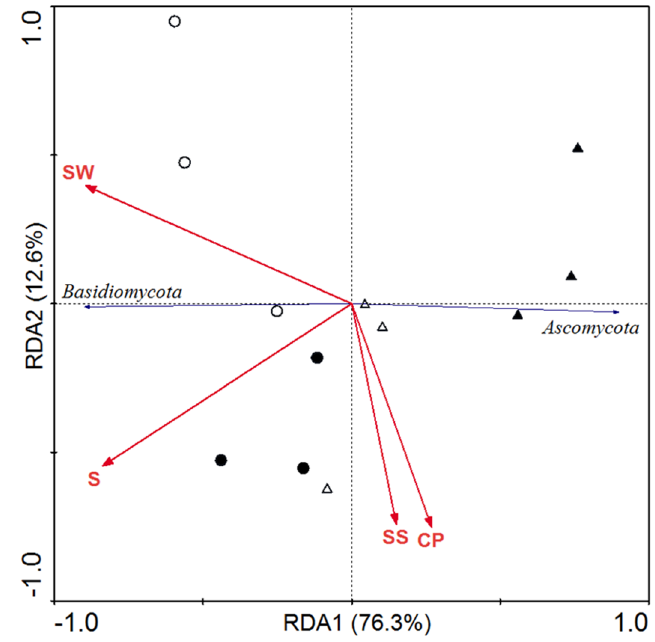
Figure 7. Redundancy analysis (RDA) plots showing the influence of physiological characteristics (water, CP, soluble sugar, and starch contents) on endophytic fungal communities.